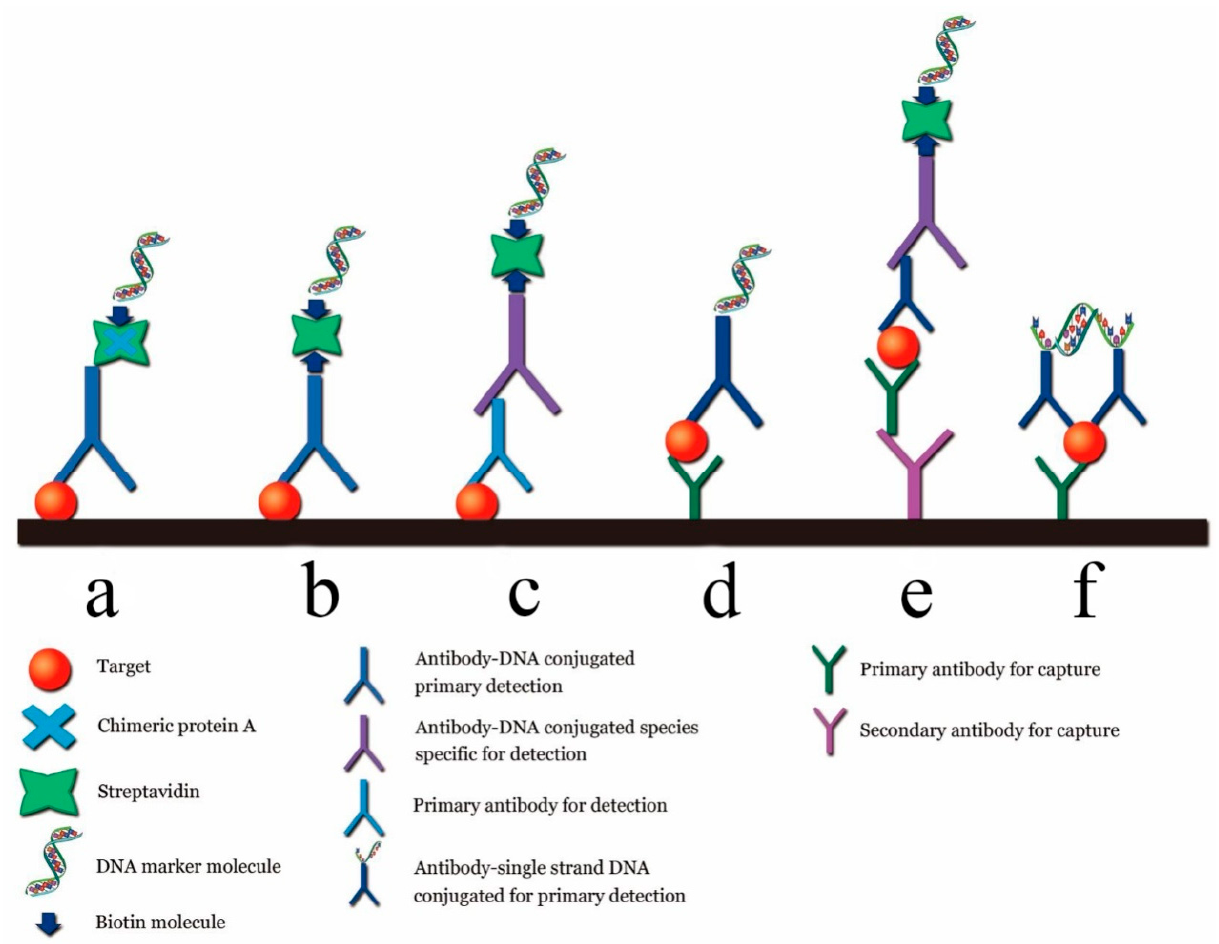
Figure 8. Different immune PCR strategies. ( a ) Original immuno-PCR; ( b ) universal direct immuno-PCR; ( c ) universal indirect im- muno-PCR; ( d ) direct sandwich immuno-PCR; ( e ) indirect sandwich immuno-PCR; ( f ) immuno-PCR by proximity ligation